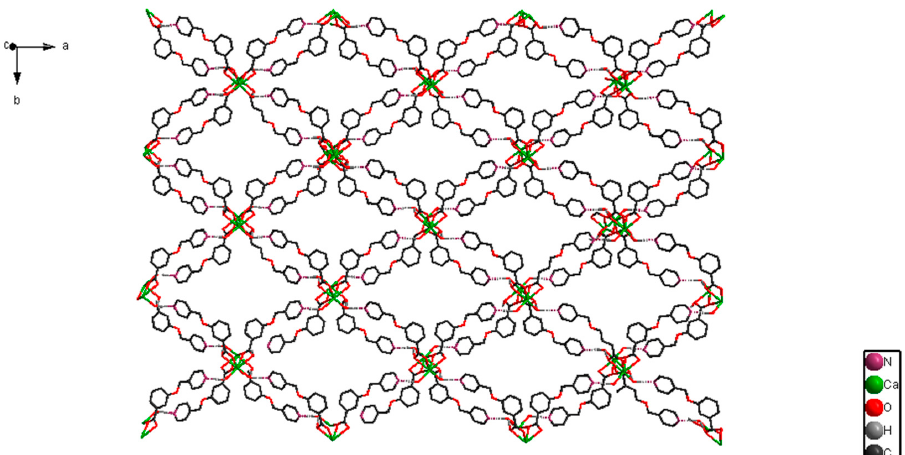
Figure 4. 3D supramolecular network structure of [CaL 2 (H 2 O) 2 ] n .